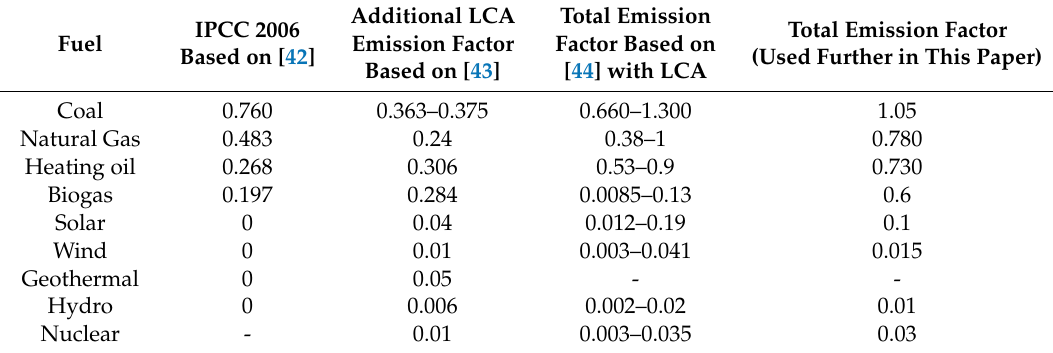
Table 2. Emission factors CO 2 expressed in tons of CO 2 per MWh.